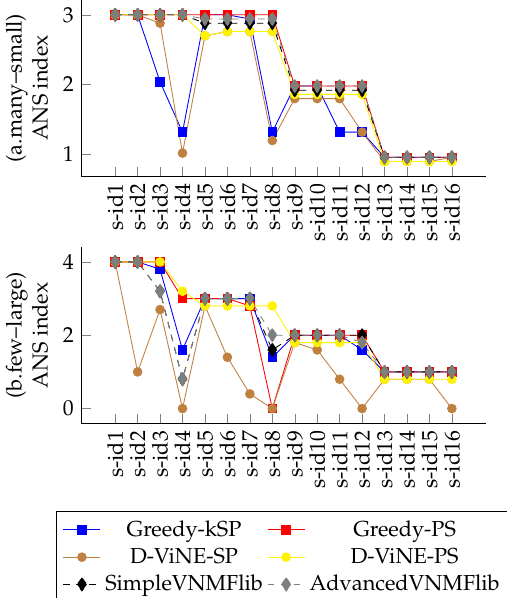
Figure 6. ANS of the examined embedding strategies.